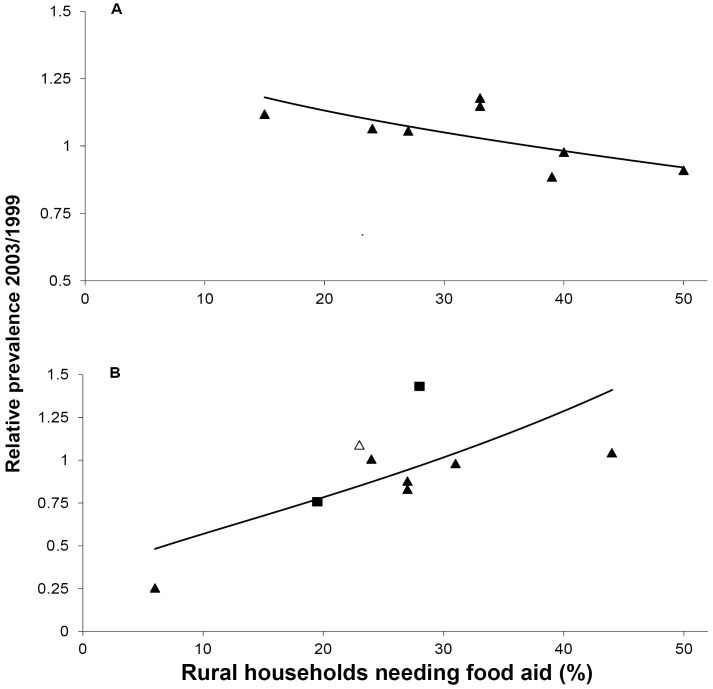
Change in prevalence of farmers at antenatal sites through the famine in relation to rural hunger.The independent variable is the proportion of rural households estimated from a humanitarian survey to be in need of food assistance in December 2002-March 2003 in the district surrounding antenatal sites. The observed values of the dependent variable are the ratio of the proportion of farmers among the women attending antenatal clinics in 2003, after the worst of the famine, to the proportion in 1999/2000, prior to the rapid rise in food prices. The fitted values are from multilevel log binomial regression (model 3, S2 Table). (A) Rural sites; (B) Non-rural sites (squares: cities, triangles: towns, open triangle: Nsanje, which is included in the analysis).